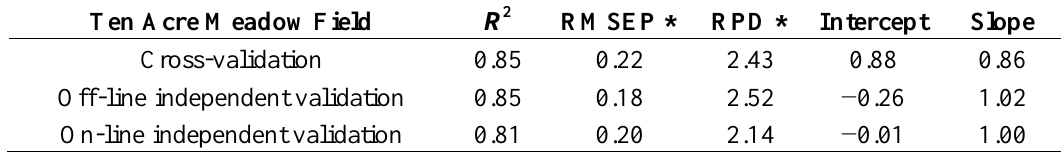
Table 3. Summary of pH model performance in cross-validation, off-line (laboratory) and on-line